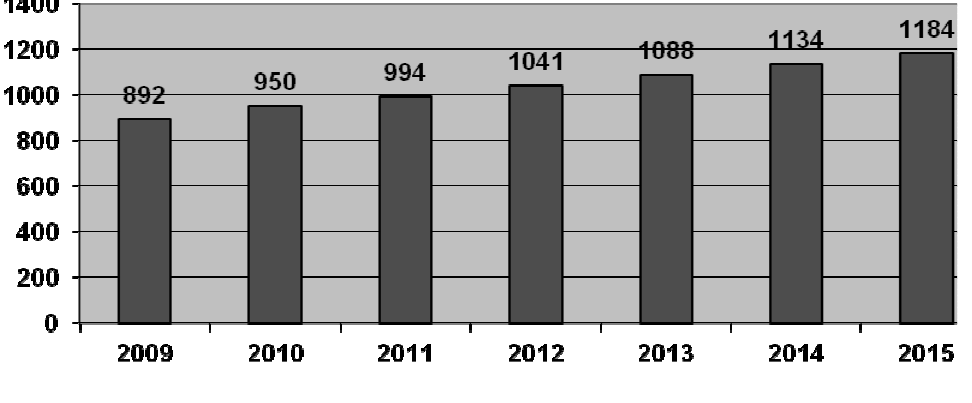
Source: World Tourism Organization